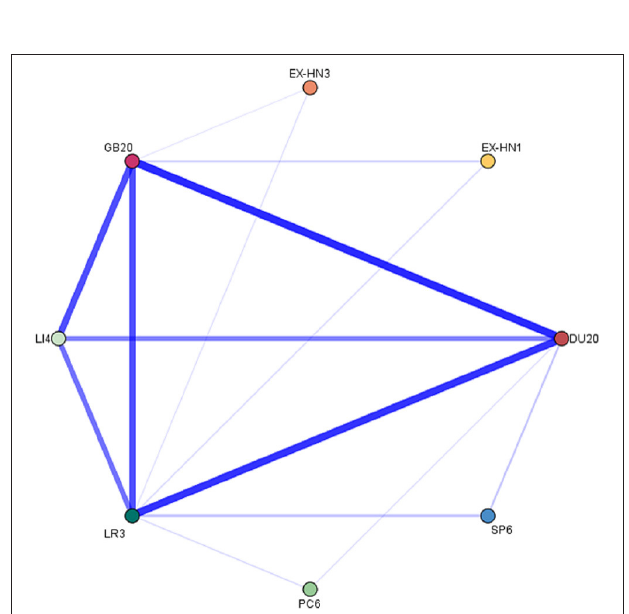
FIGURE 10 | Acupoints association network of acupuncture for TS treatment.